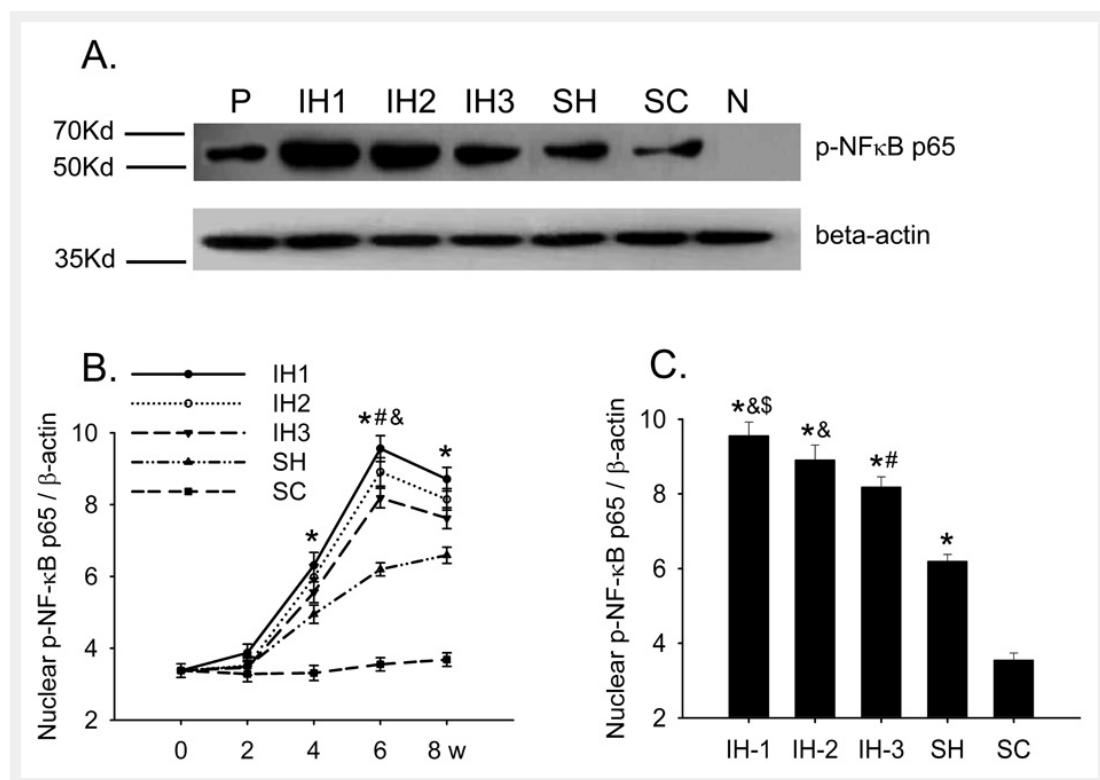
Figure 4 Temporal changes of phosphorylated NF-κB p65 in nuclear extracts of aorta endothelial cells. (A) A representative Western blot showed that increased levels of p-NF-κB p65 in nucleus were observed in IH groups as compared to those in SH and SC group. Positive control, referred to as P, was whole-cell extracts from cultured hela cells stimulated with 10 ng/ml TNF-α. The whole-cell extracts further treated with lamda phosphatase were used as negative control, labelled as N in the blot. The levels of β-actin were used as the internal standard of protein content in each lane. (B) The intensity of phosphorylated NF-κB p65 was normalised to that of β-actin, which was then plotted as mean ± SE to show the activity changes of this transcription factor at various time points (* P <0.05 IH1, 2, 3 and SH group vs SC group; # P <0.05 IH 1, 2, 3 vs SH group; & P <0.05 IH1 vs IH3 group, n = 7 or 8 in each group). (C) The normalised nuclear levels of phosphorylated NF-κB p65 at 6 th week were also re-plotted as bar graphs (* p =0.01 compared with SC group; # P =0.05 compared with SH group; & P =0.01 compared with SH group; $ P =0.05 compared with IH-3 group, n = 7 or 8 in each